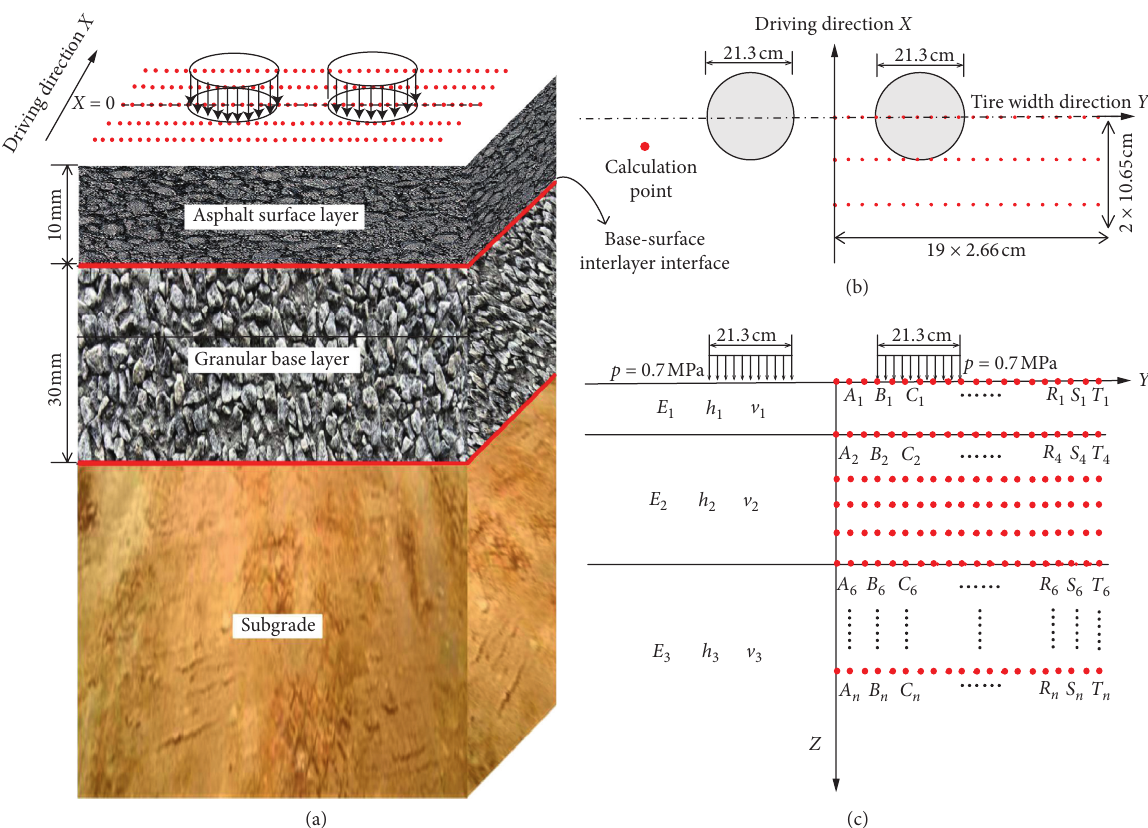
Figure 4: Pavement structure of BISAR (not to scale). (a) Pavement structure. (b) Plane calculation point. (c) Profile calculation point.